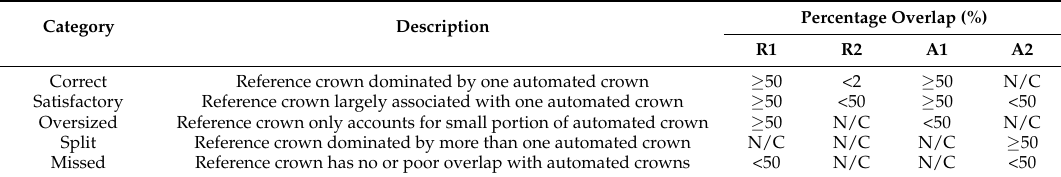
Table 6. Accuracy assessment categories for the tree crown delineation accuracy